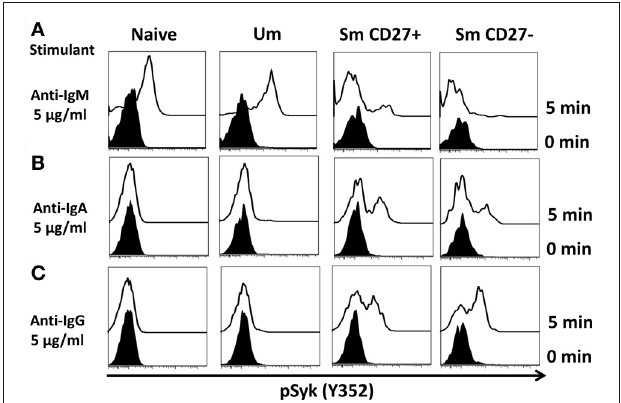
and IgD, showed robust Syk phosphorylation after PBMC stimulation with anti-IgM (A) . Interestingly, a small peak was detected in Sm CD27 + cells, which probably corresponds to IgM cells present in Sm CD27 + cells ( Figure 1D ). No phosphorylation of Syk was detected in Sm CD27 − B cells (A) . PBMC were also stimulated with anti-IgA and -IgG ( B and C , respectively). Syk phosphorylation was detected in Sm CD27 + and Sm CD27 − , but not in naïve and Um B cells ( B and C